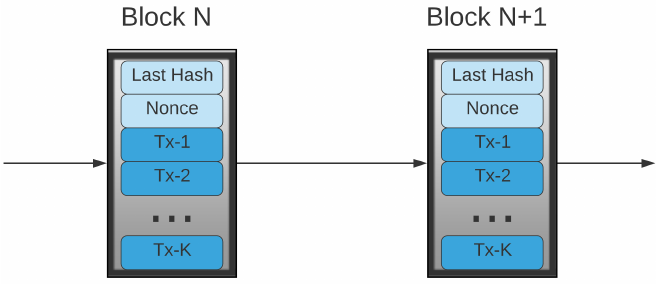
Figure 2. A diagram showing connections between blocks in blockchain technology, providing these connections through hashes.